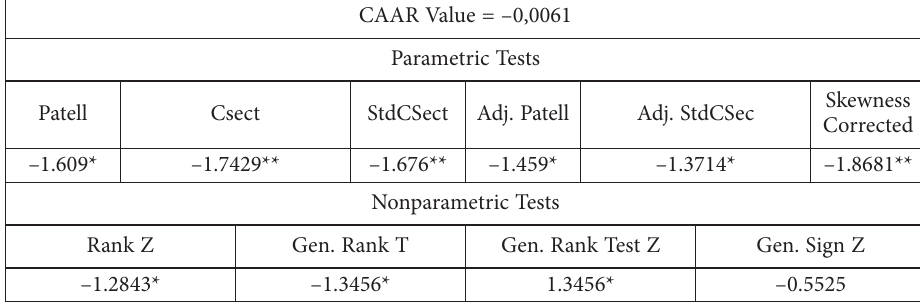
Table 2. Results of the parametric and nonparametric tests for the 7-day event study (source: own design) CAAR Value =